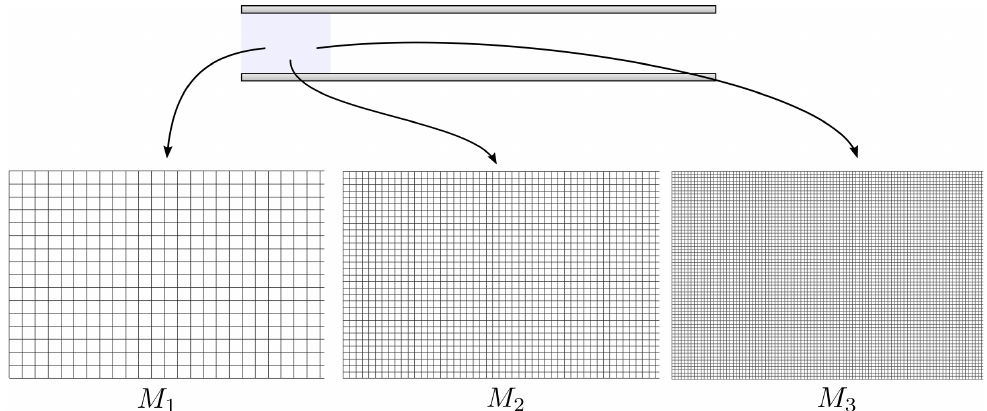
Figure 4. Three consequently refined uniform meshes used in this